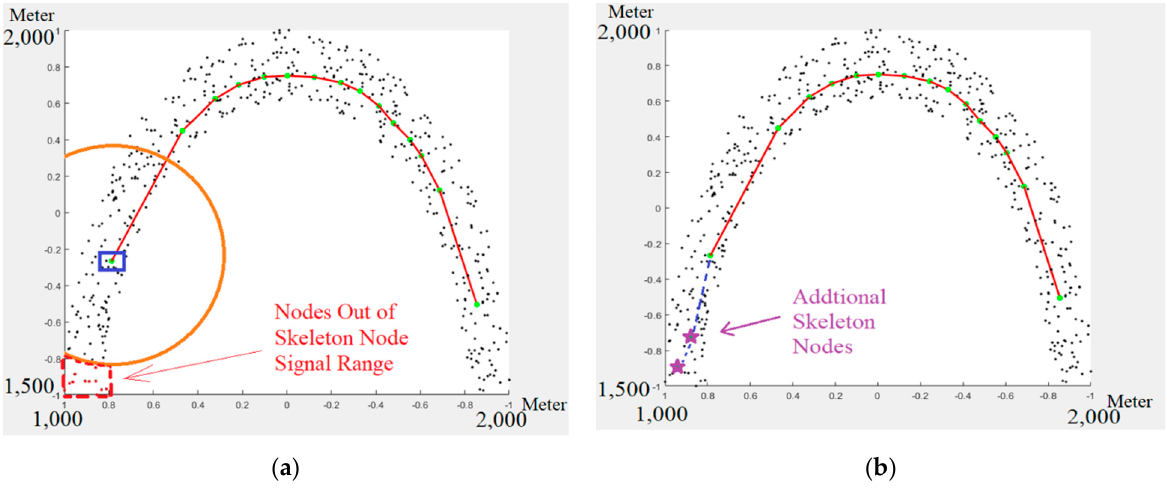
Figure 10. ( a ). Nodes out of skeleton nodes’ RF range; ( b ). added skeleton nodes.